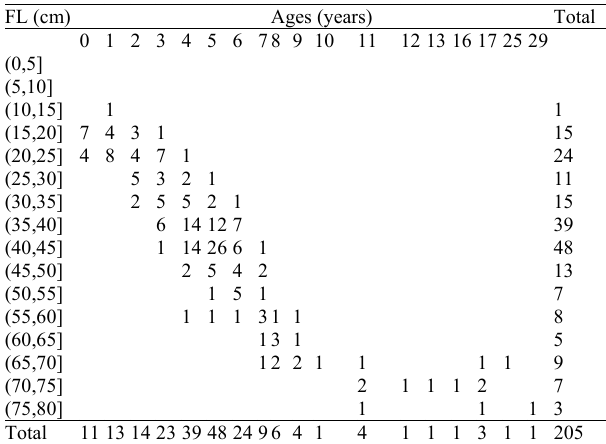
Table 1. Frequency distribution of fish fork length (FL) by age (years) of the dog snapper Lutjanus jocu from Abrolhos